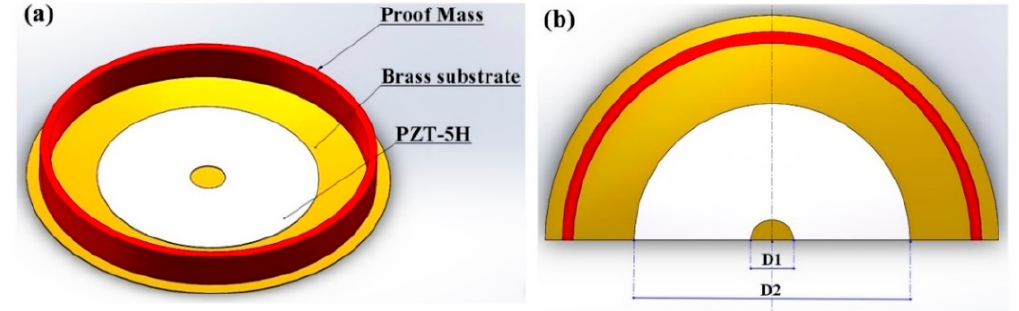
Figure 5. Schematic structure ( a ) and structural parameters ( b ) of the PCD energy harvester with a hole-digging piezoelectric ceramic disk.